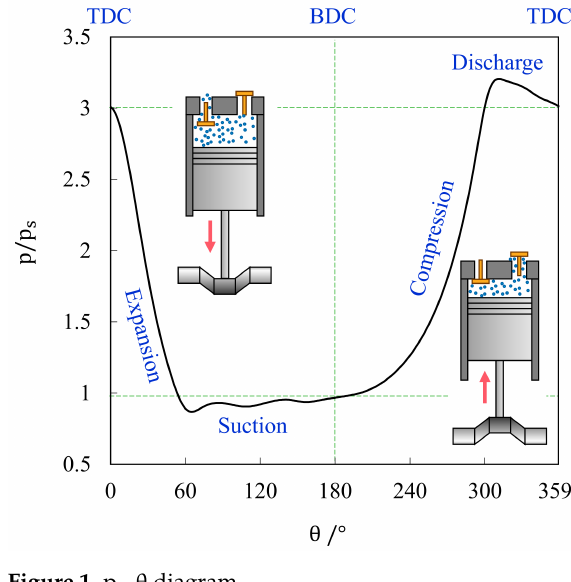
Figure 1. p − θ diagram.